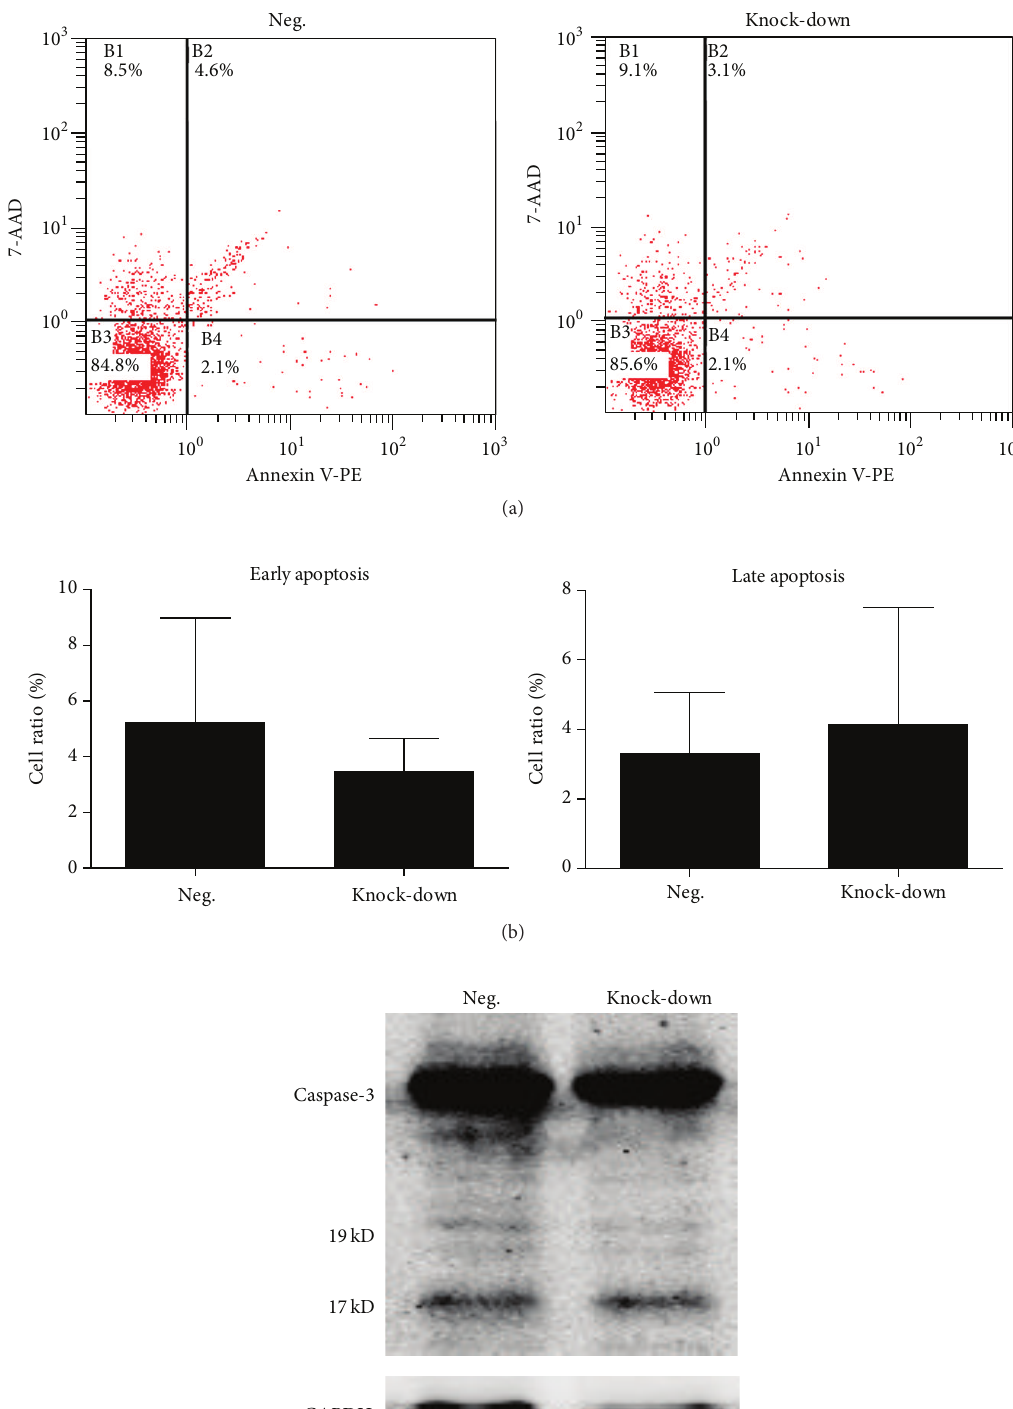
Figure 6: Apoptosis analysis of transfected BM-MSCs. (a) Representative flow cytometric results of apoptosis analysis in different groups. (b) Percentage of early and late apoptosis cells in different groups. Data was presented as mean ± SD. (c) Western blot analysis of Caspase-3 in different groups. The 17 kD and 19kD bands represented cleaved